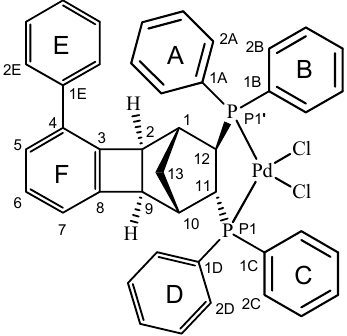
Figure 2. The molecular structure of the complex [Pd( 6q )Cl 2 ].